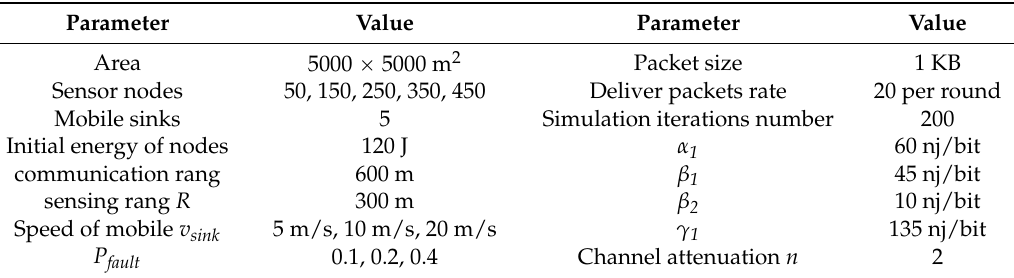
Table 3. Simulation